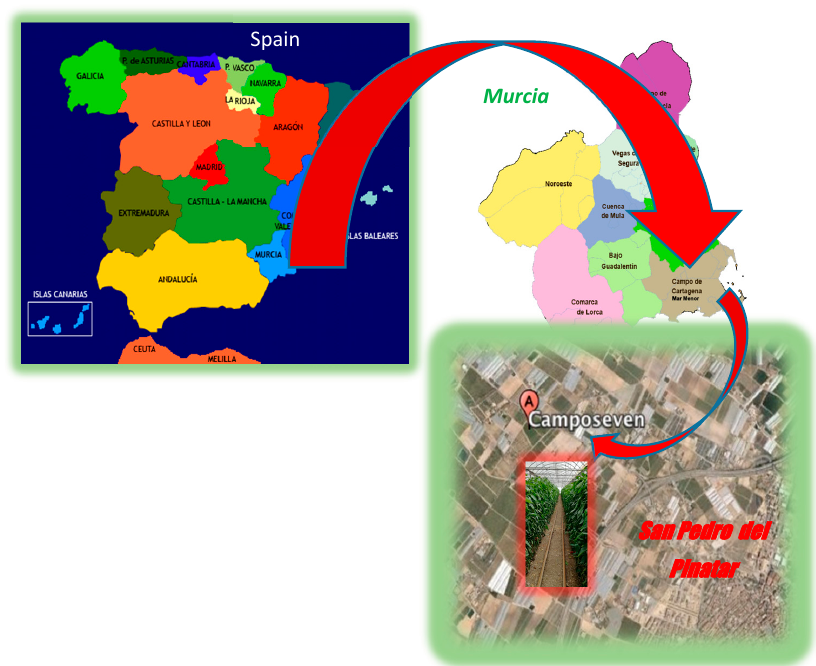
Figure 4. Location of the case study.